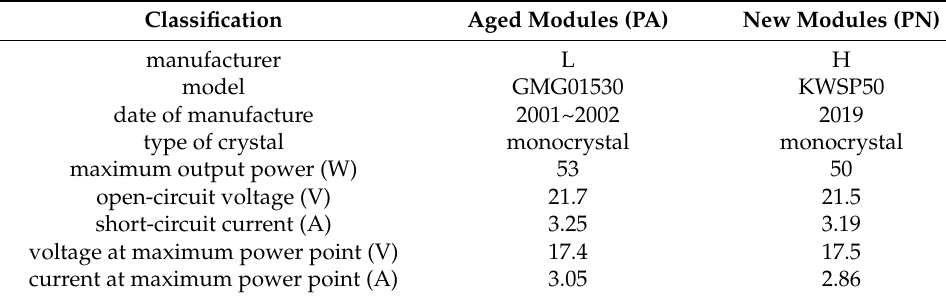
Table 2. Specification of aged and new PV modules.